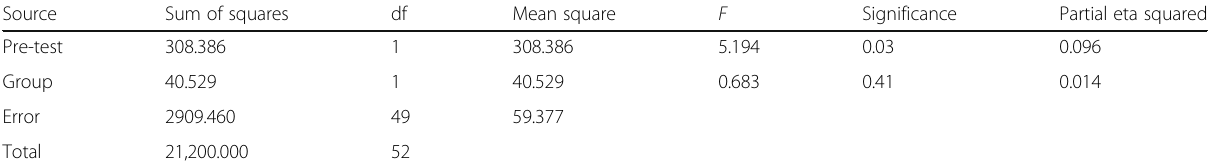
Table 5 Result for ability to initiate interactions with others between the two intervention groups Source